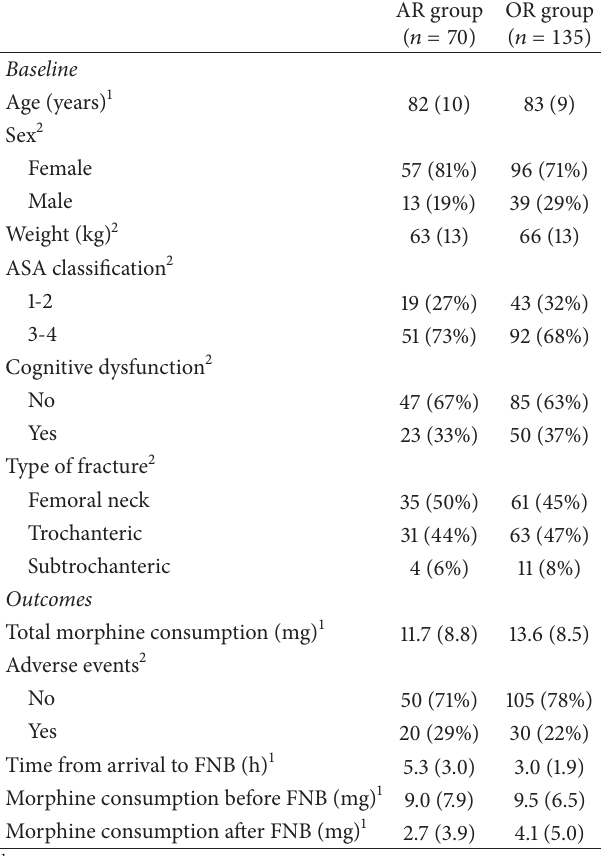
Table 1: Characteristics of the patients and main